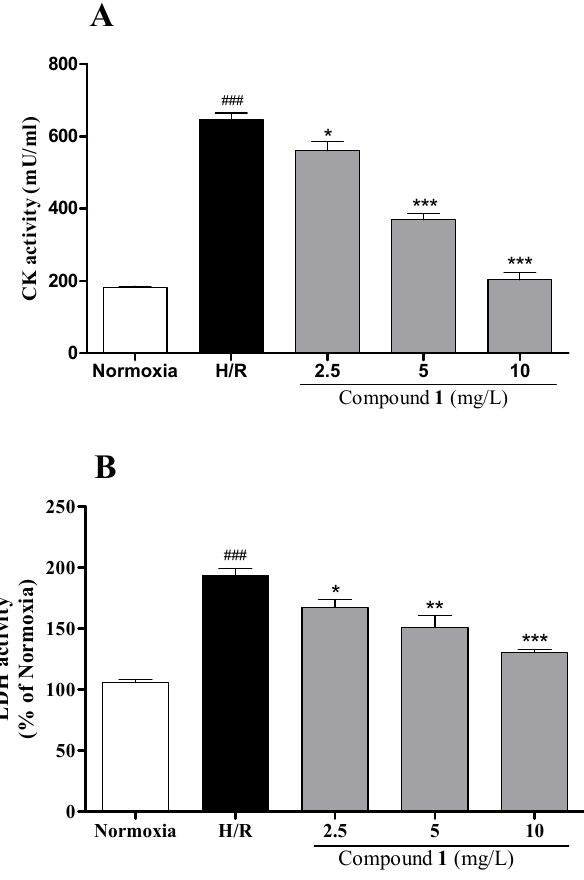
Figure 4. Effects of compound 1 on myocardial enzymes markers in H9c2 cells subjected to H/R. ( A ) Lactate dehydrogenase (LDH); ( B ) Creatine kinase (CK). Data represents mean ± SEM. Myocardial enzymes markers were assessed by a commercial LDH and CK activity assay kit. The results were reproduced by six independent experiments. ### indicates p < 0.001 for the H/R group vs. the normoxia group; * indicates p < 0.05, ** indicates p < 0.01, *** indicates p < 0.001 for each treatment group vs. H/R group.